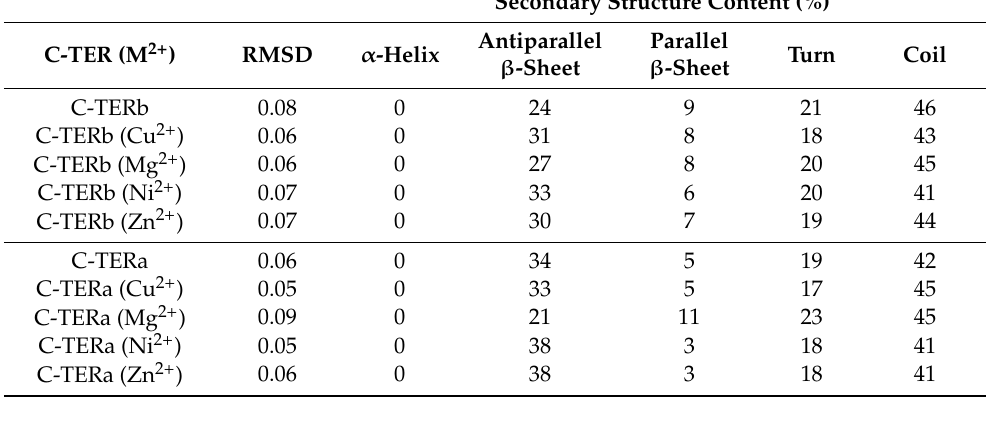
Table 2. BeStSel secondary structure content estimations and fit-associated RMSD values of C-TERb and C-TERa (C C-TER = 5 µ M) incubated in TBS at ~20 ◦ C for 72 h in the presence of Cu 2+ , Mg 2+ , Ni 2+ , and Zn 2+ cations (C M2+ = 100 µ M).